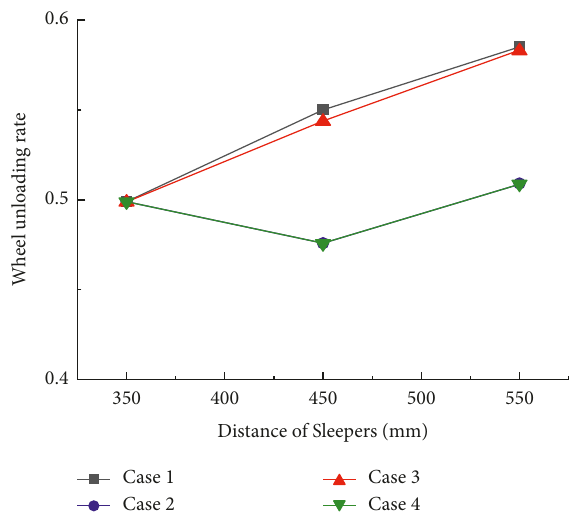
Figure 18: The maximum value of the wheel unloading rate in different